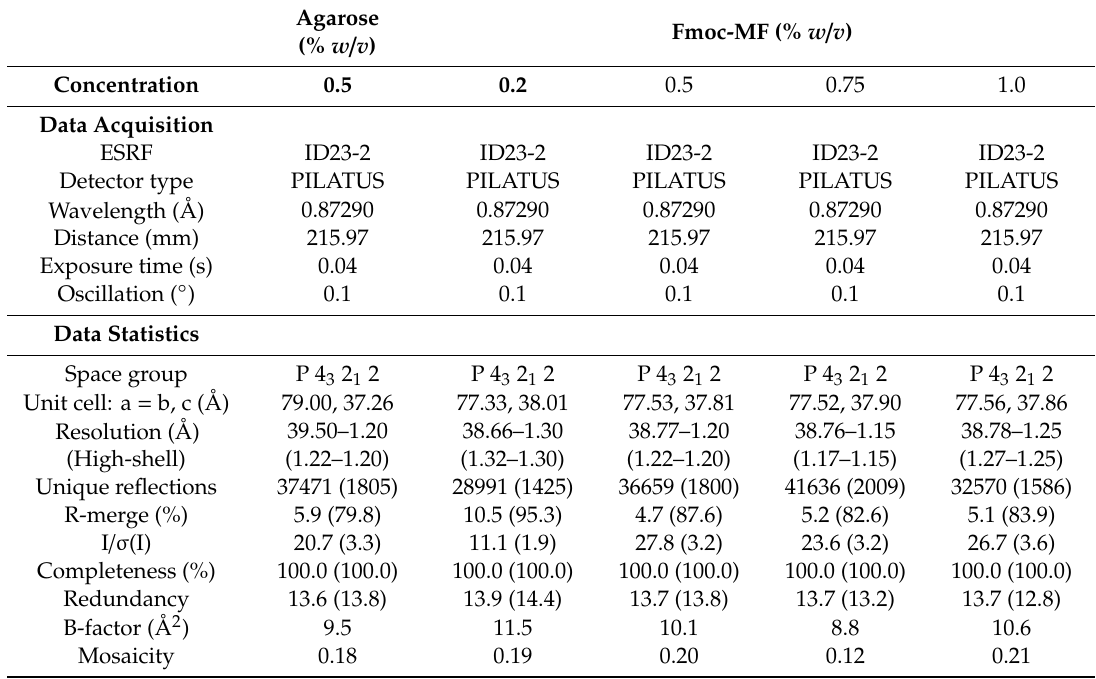
Table 2. Summarized the data collection conditions and final statistical values of lysozyme crystals in Fmoc-MF and in agarose hydrogels (data in brackets correspond to high-resolution shell).